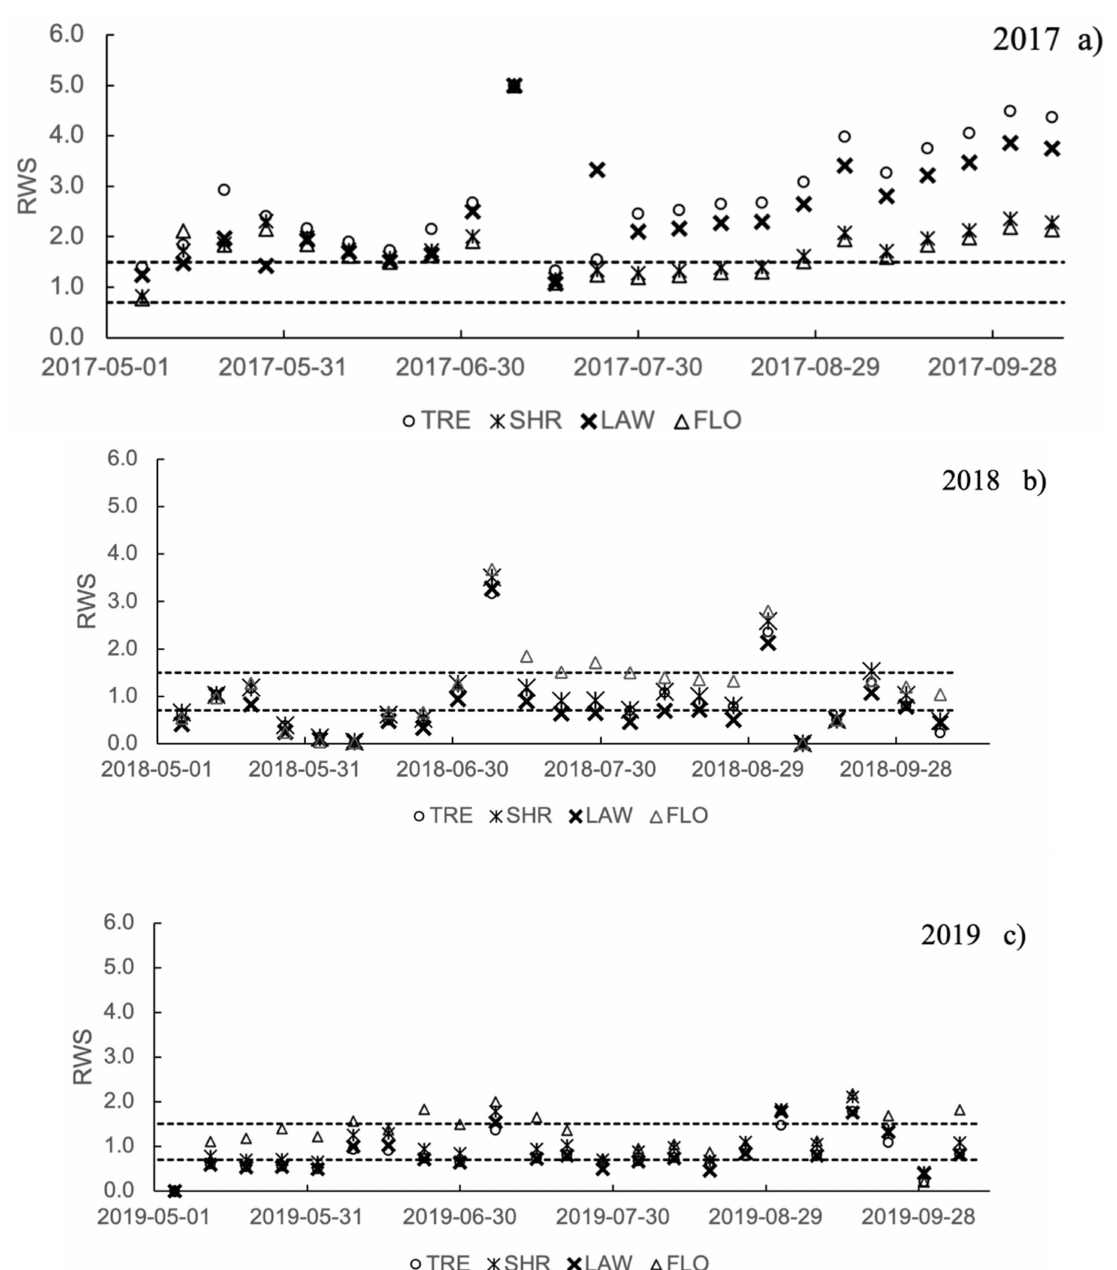
Figure 7. RWS indicator calculated weekly: ( a ) 2017, ( b ) 2018, and ( c ) 2019. (0.75 < RWS < 1.5, optimal